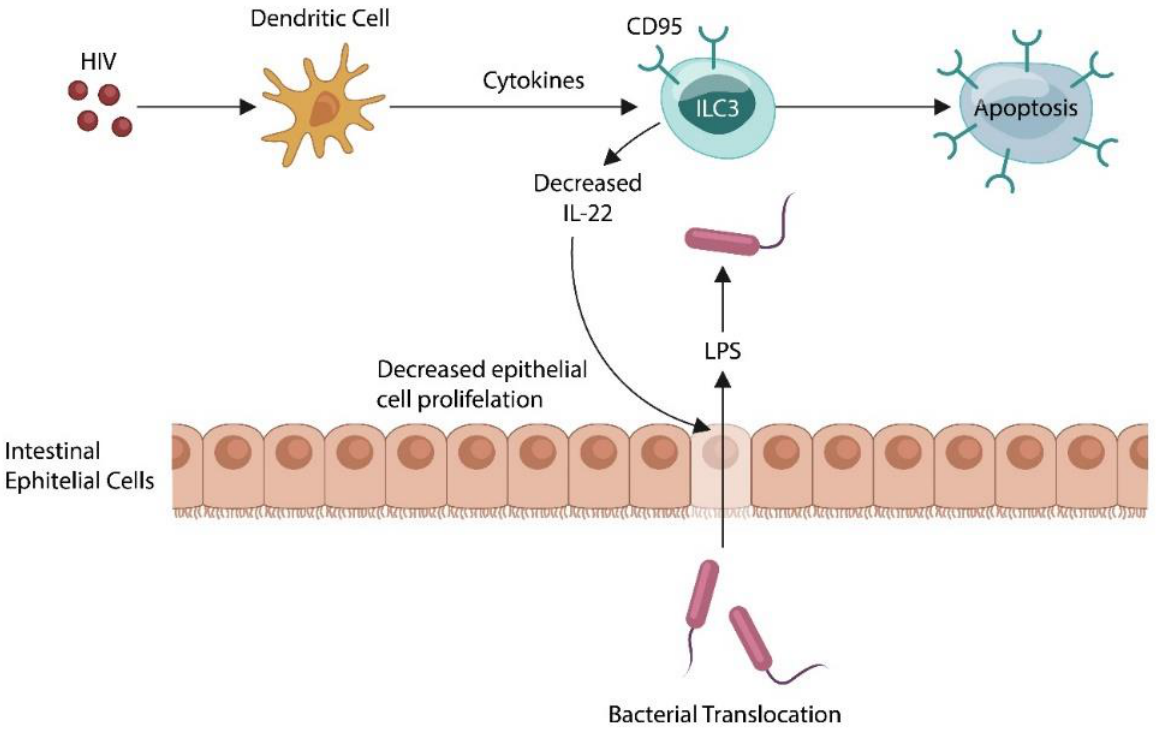
Figure 2. HIV induces apoptotic loss of ILC3, lowering IL22, the guardian of the gut barrier. This, in turn, promotes the translocation of intestinal microbes and their molecules into the systemic circulation. Activated host immunity maintains a state of low-grade inflammation that characterizes many diseases of uncertain etiology.